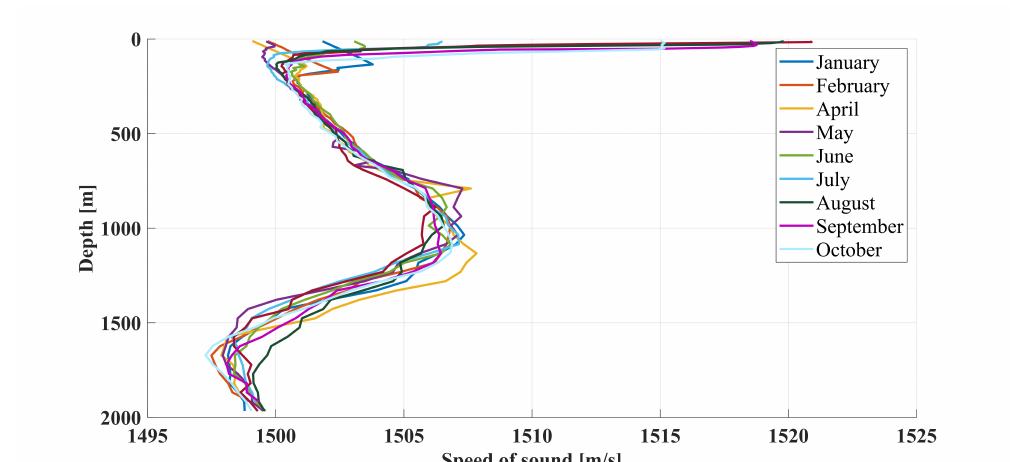
Figure 2. Seasonal variation of the speed of sound in column water. The vertical sound speed profile has been considered in the propagation of noise through the sea water. Data of salinity and temperature are missing for March, November, and December.